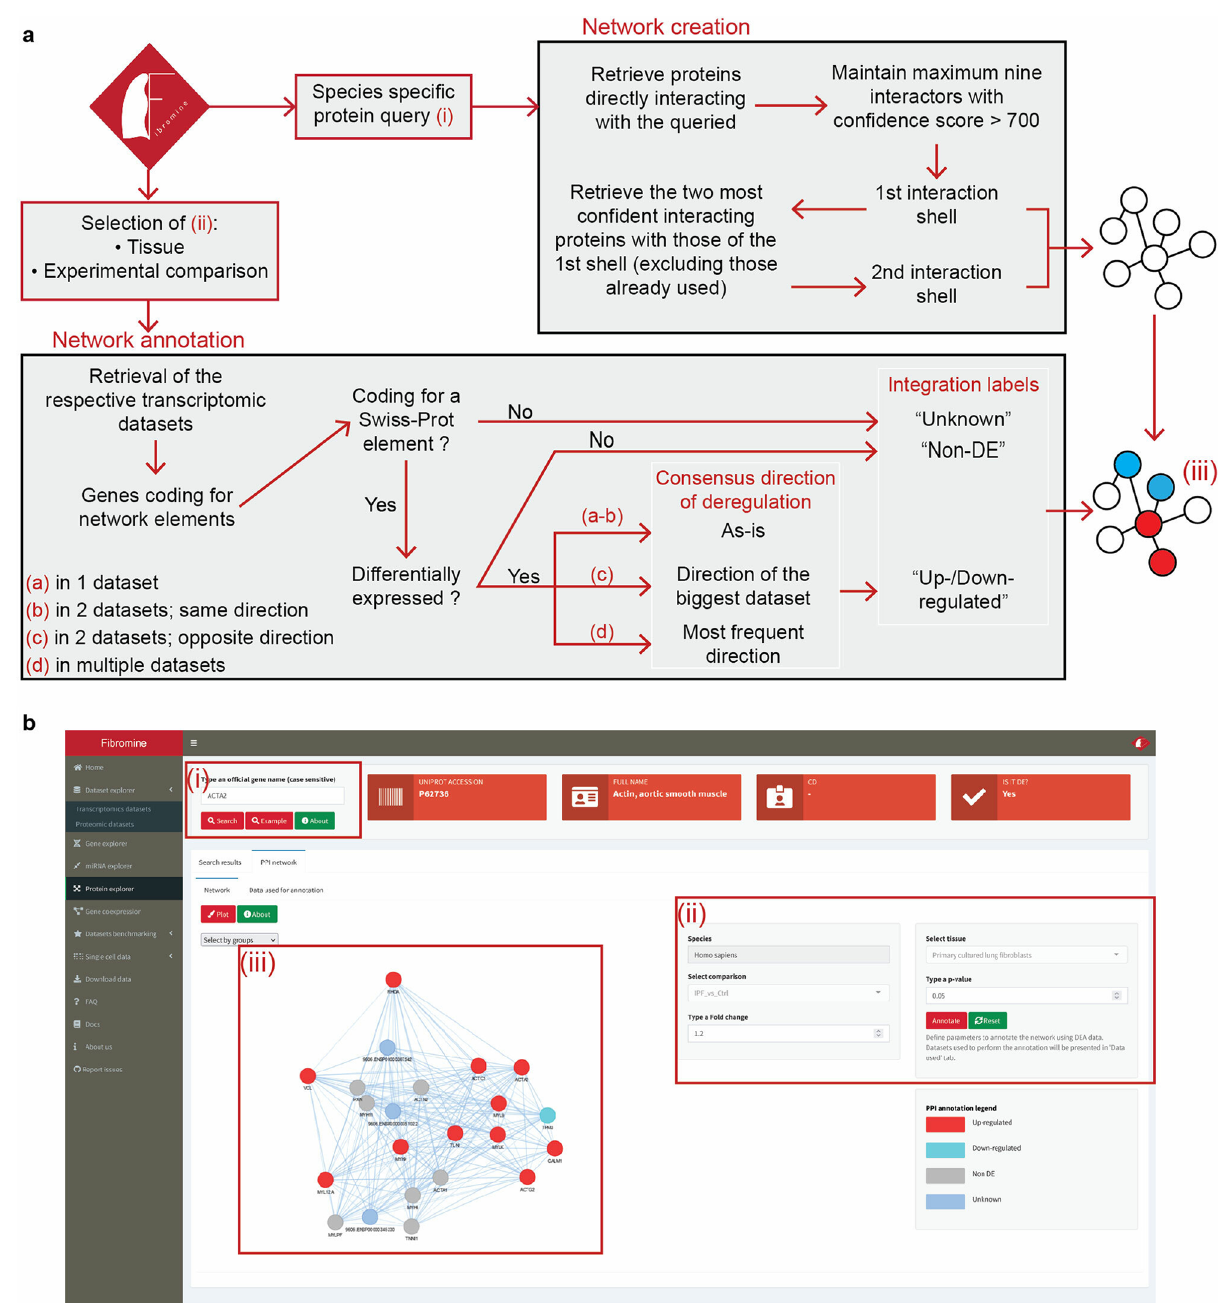
Figure 4. Protein–protein interaction network creation and condition-specific annotation workflow. (a) Protein explorer back-end process for the creation and annotation of protein–protein interaction networks. Data on protein relationship and interactions confidence are retrieved from Fibromine included UniProt data. Boxed and Latin numbers in red correspond to front-end elements presented in (b) . (b) The pipeline on the front- end of Protein explorer : (i) specific protein query, (ii) selection of experimental parameters to consider, (iii) annotated network. Figure was created using https:// www. google. com/ slides/